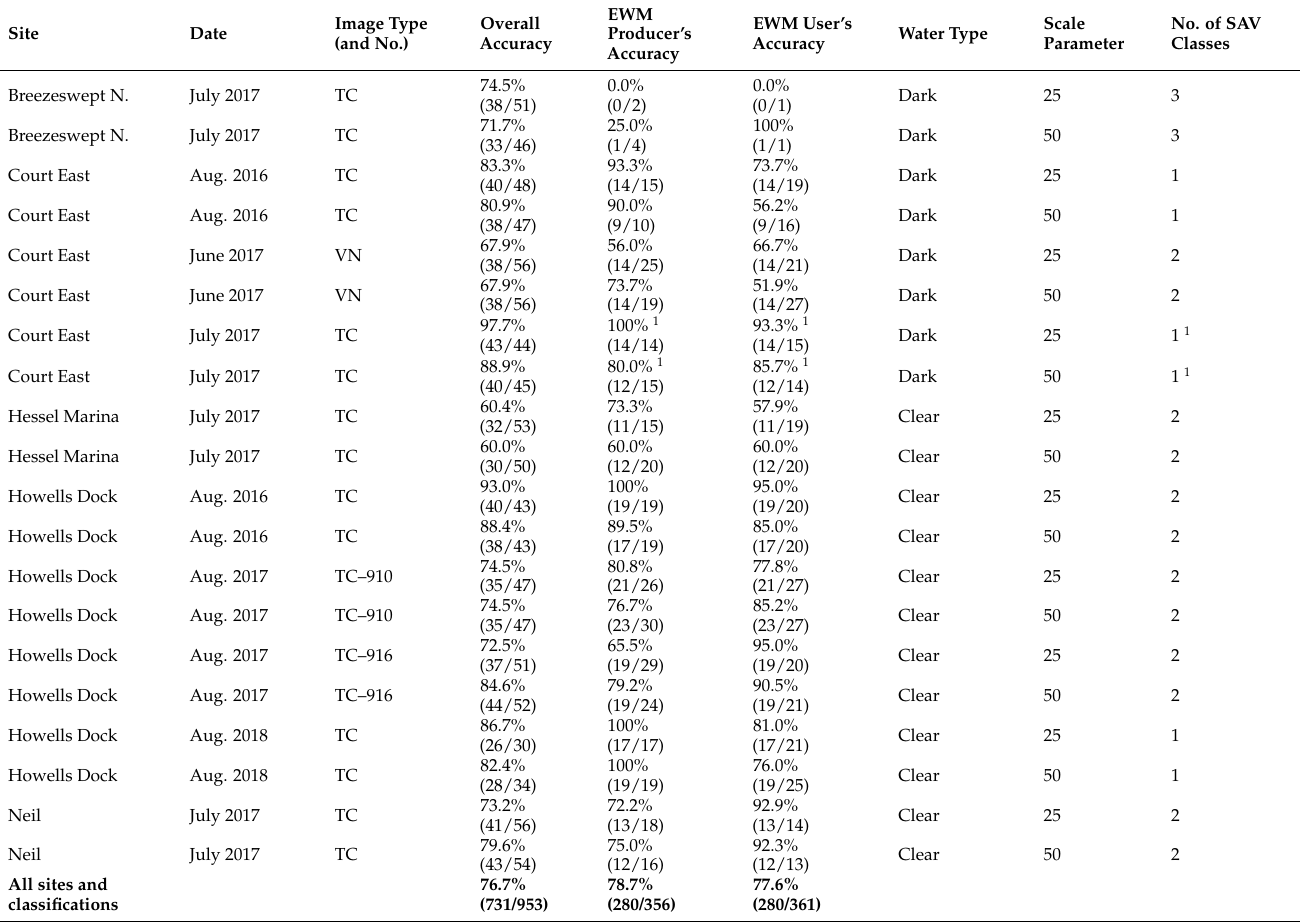
Table 5. Summary of error analysis results for 2016–2018